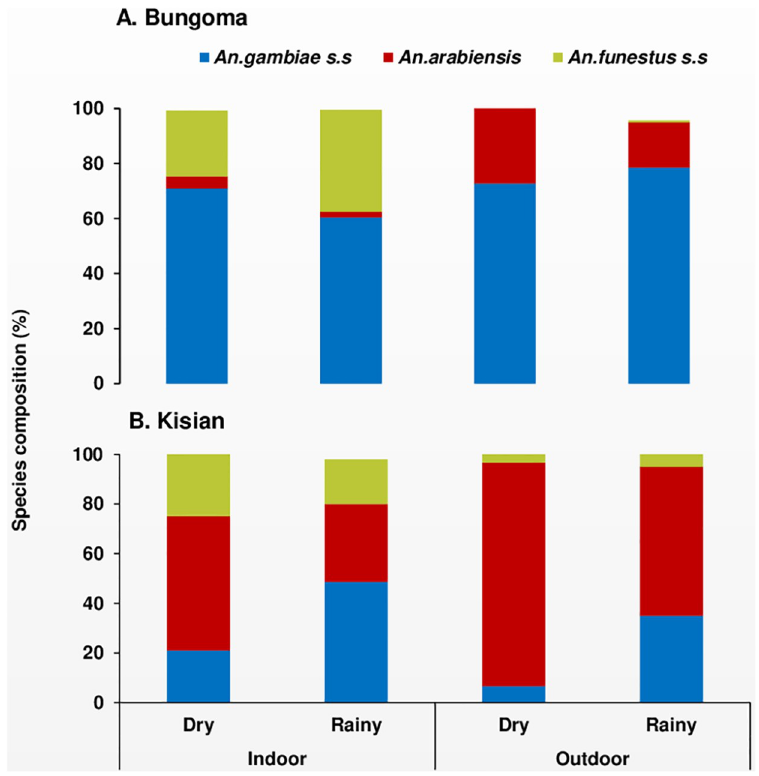
Fig 2. Seasonal composition and Anopheles sibling species composition resting indoors and outdoors in A: Highland site (Bungoma) and B: Lowland site (Kisian), western Kenya.